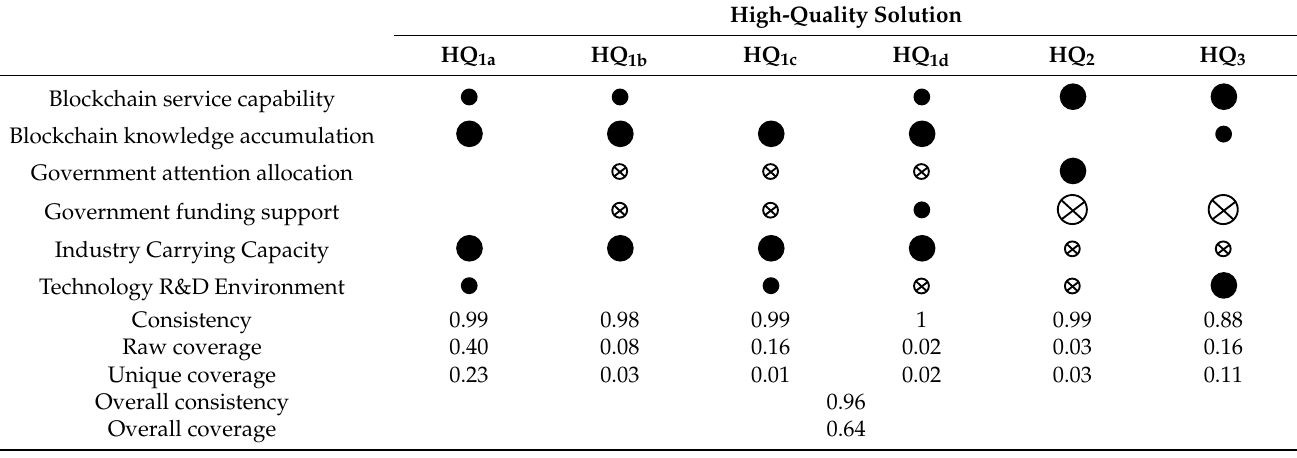
Table 8. Results of the robustness test with alternative crossover points.